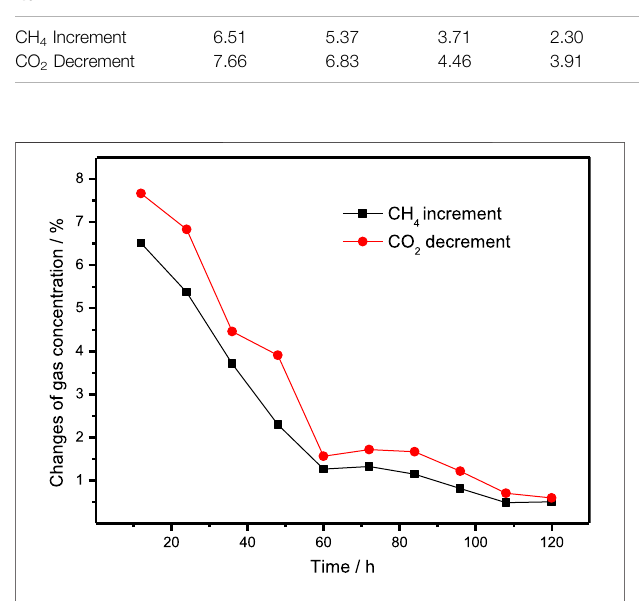
TABLE 2 | The CH 4 increment and CO 2 decrement in gas samples collected every 12 h in Experiment 2. Time item